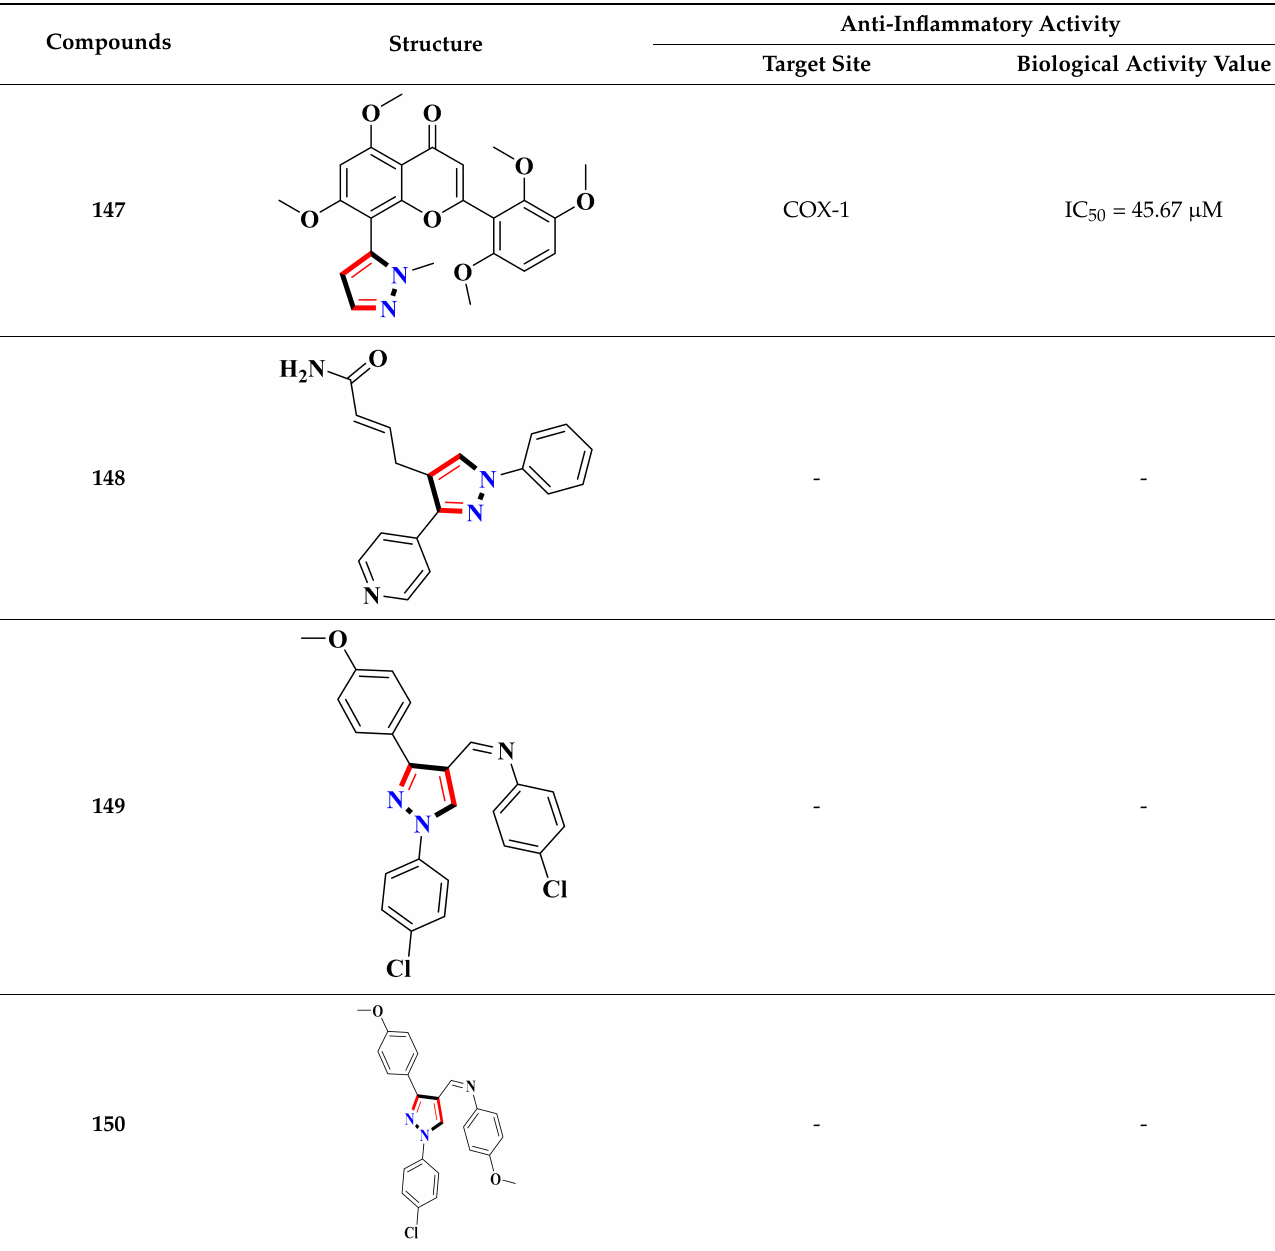
Table 11. Representative compound structures 147 to 161 and their anti-inflammatory